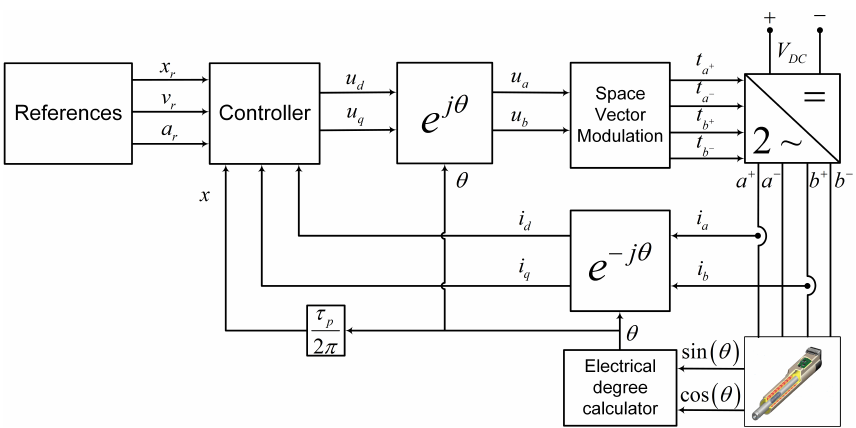
Figure 2. Typical control scheme of polysolenoid linear